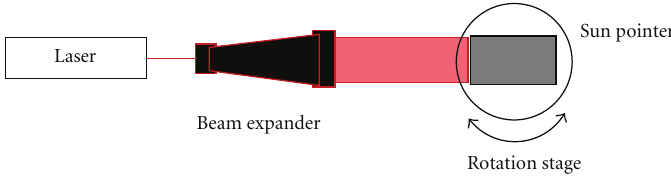
Figure 9: Test setup for the laboratory tests of the sensors.